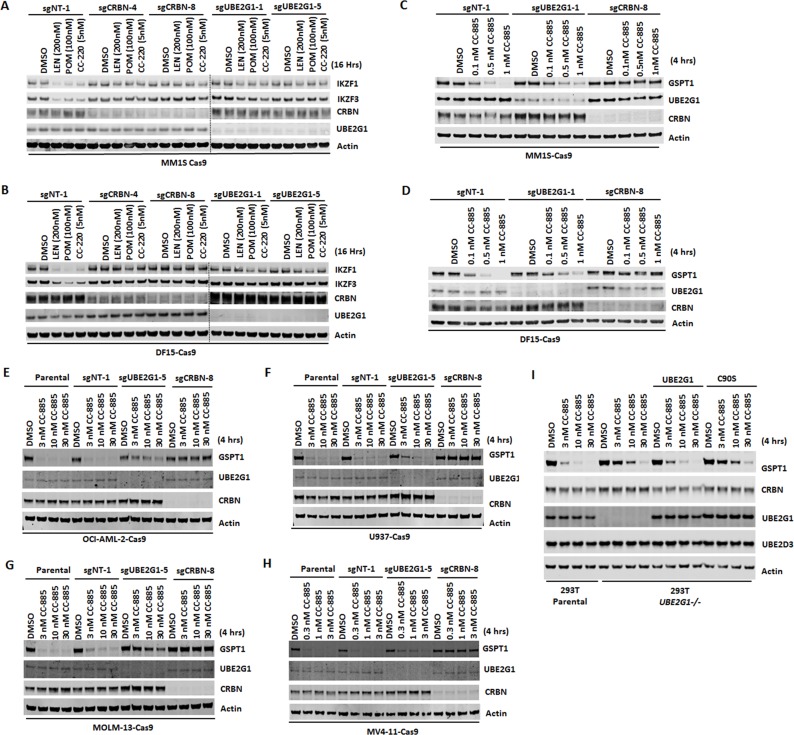
Elimination of UBE2G1 blocks the degradation of cereblon neomorphic substrates recruited by lenalidomide and CC-885.(A–F) Immunoblot analysis of DF15-Cas9 cells (A and C), MM1S-Cas9 cells (B and D), OCI-AML2-Cas9 cells (E), U937-Cas9 cells (F), MOLM-13-Cas9 cells (G) and MV4-11-Cas9 cells (H) transduced with lentiviral vectors expressing non-targeting, UBE2G1-specific or CRBN-specific sgRNAs. Cells were treated with lenalidomide for 16 hr (A and B), or CC-885 for 4 hr (C–H) at the indicated concentrations. (I) Immunoblot analysis of 293T parental or UBE2G1-/- cells stably expressing UBE2G1 wild-type or C90S mutant. Cells were treated with CC-885 at the indicated concentrations for 4 hr. All results shown in this figure are representative of three independent experiments.